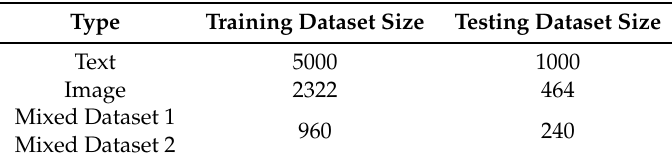
Table 6. Training and testing dataset size.